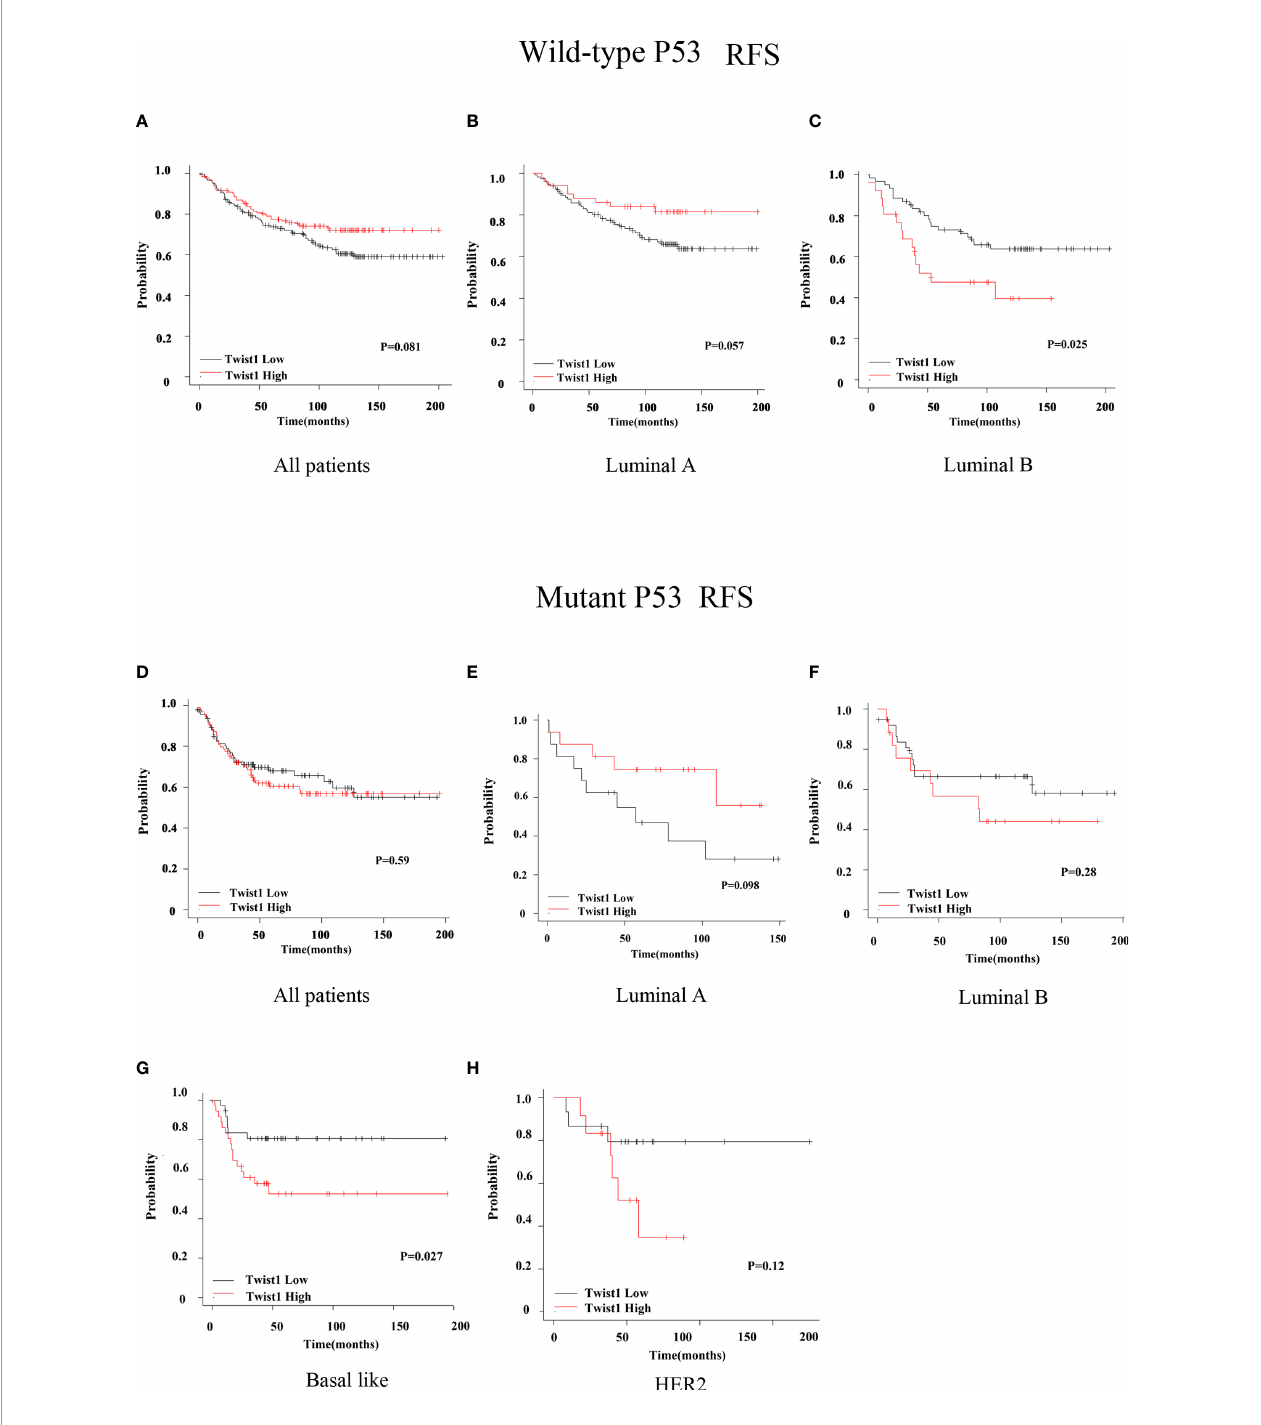
FIGURE 2 | Comparison of RFS for wild-type or mutant p53 breast cancer patients with different Twist1 levels. (A – C) Different Twist1 expression levels did not differ in RFS ( P > 0.05) among all wild-type p53 breast cancer patients (A) and luminal A (B) and luminal B (C) subtypes. (D – H) Different Twist1 expression levels did not differ in RFS ( P > 0.05) among all mutant p53 breast cancer patients (D) and luminal A (E) , luminal B (F) , and HER2 (H) subtypes. (G) High Twist1 expression had the worst RFS ( P < 0.05) among the mutant p53, basal-like breast cancer